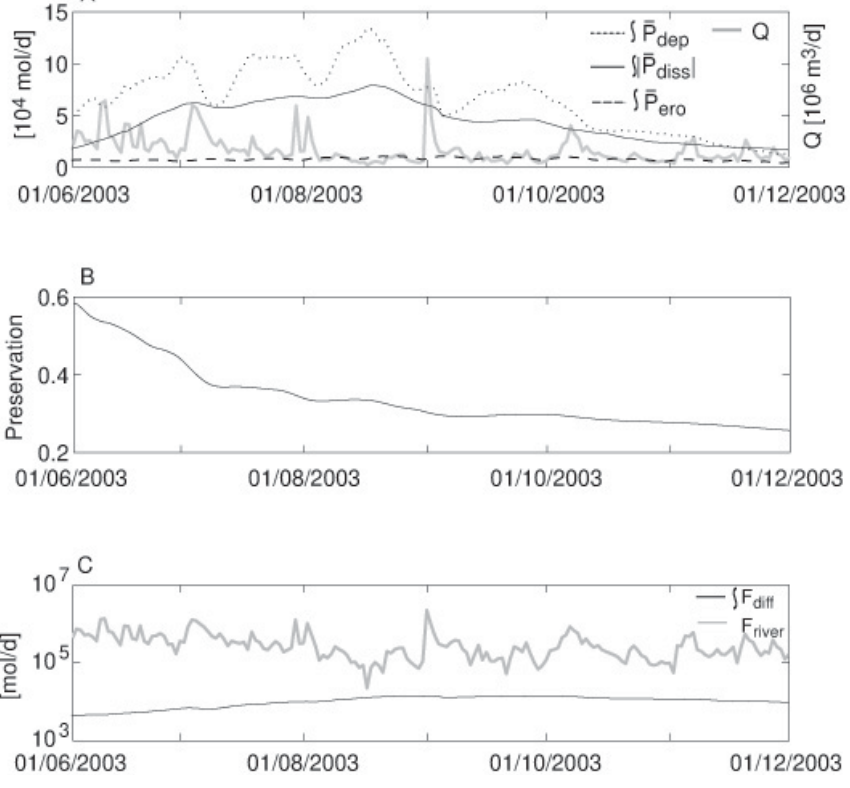
Fig. 10. Temporal evolution of (A) area-integrated depositional flux R P dep , dissolution of biogenic silica R P diss and erosion flux R P ero in the freshwater tidal reaches (km170–km100) of the Scheldt estuary, as well as daily river discharge Q . (B) Preservation of deposited BBSI in the freshwater reaches. (C) Comparison of logarithmic, area-integrated (km170–km100) diffusive flux of silica and logarithmic, daily riverine (Scheldt + Dender) silica influx into the tidal freshwater reaches of the Scheldt.